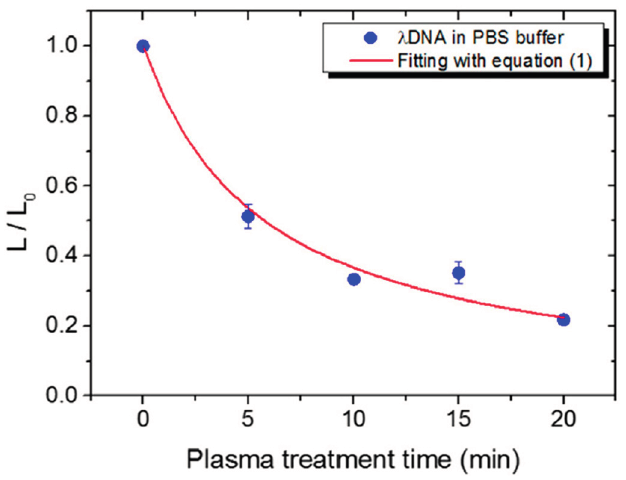
Figure 10. Representation of the rate of change of DNA molecule average length (where L 0 is the DNA length before plasma exposure, and L is the length after the exposure) in PBS solution treated by APP at various exposure times. Adapted from [59] with the permission of Elsevier, Inc.,